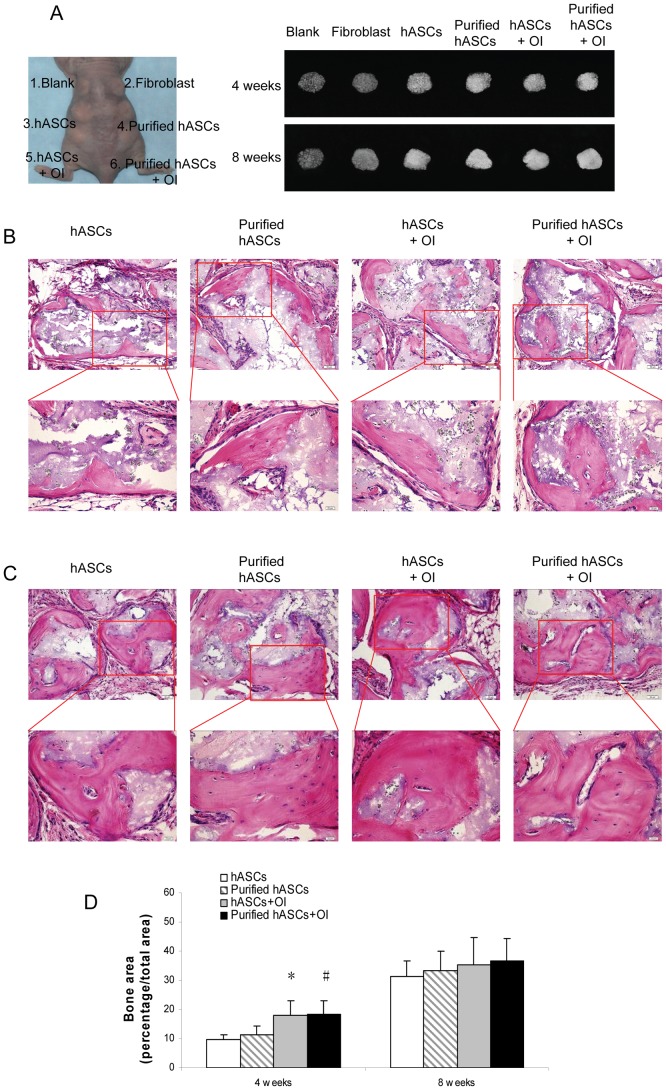

In vivo bone formation by human adipose-derived stromal cells (hASCs).A) Gross observation and soft X-ray examination showed that hASCs, purified hASCs, hASCs that had undergone osteoinduction (OI) (hASCs+OI) and purified hASCs+OI formed bone-like tissues of relatively higher density than blank controls and fibroblast controls. B) Hematoxylin and eosin staining showed bone-like tissues with the typical structure of osteocyte lacunae in all four groups 4 weeks after implantation. The scale bar represents 50 µm. C) Eight weeks after implantation, the area of bone formation was larger in all four groups. The scale bar represents 50 µm. D) Quantitative measurements of bone-like tissues demonstrated that, 4 weeks after implantation, the area of bone formation was significantly increased in hASCs+OI and purified hASCs+OI compared with hASCs and purified hASCs without OI. However, 8 weeks after implantation there were no significant differences among the four groups. *
P<0.05 compared with hASCs without OI; #
P<0.05 compared with purified hASCs without OI.